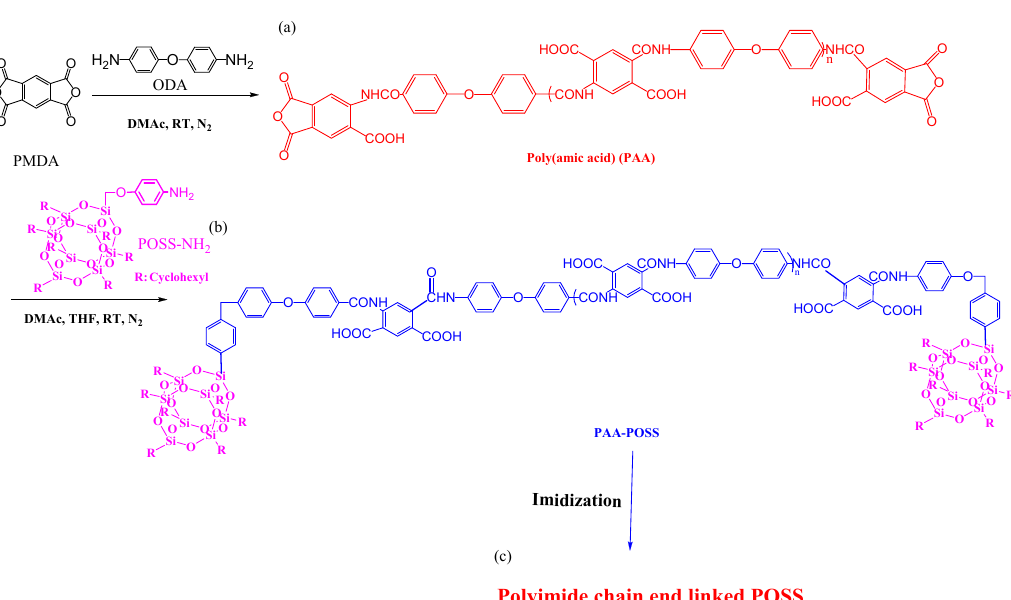
Figure 6. Preparation of ( a ) poly(amic acid) (PAA); ( b ) PAA/POSS nanocomposites; and ( c ) PI linked through its chain ends to POSS [76]. Reproduced with permission from the American Chemical Society.